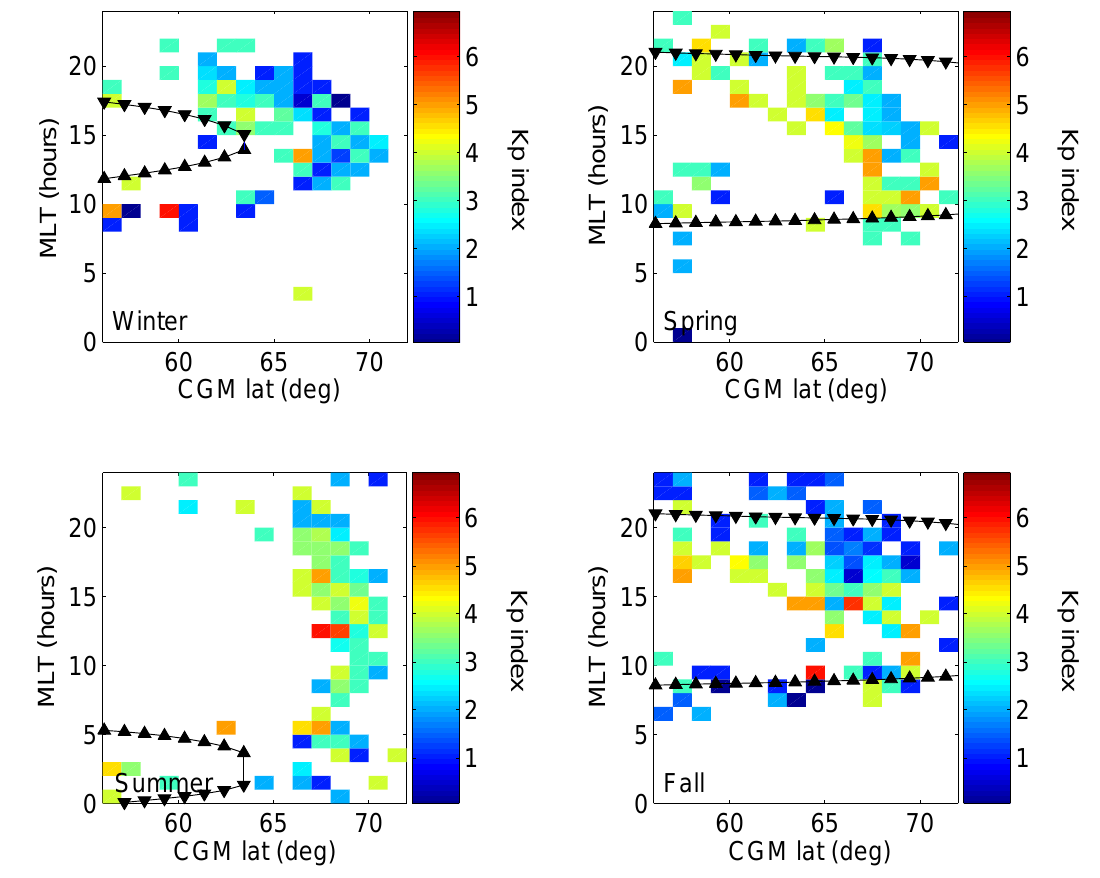
Fig. 2. The corrected geomagnetic latitudes and magnetic local times of the equatorward edges of the troughs observed in 2003. The bin width is 1 ◦ in latitude and 1h in local time. The colour code indicates the mean K p during observations included in each bin. Also shown is the solar terminator at equinoxes and solstices, where triangles point towards the dayside